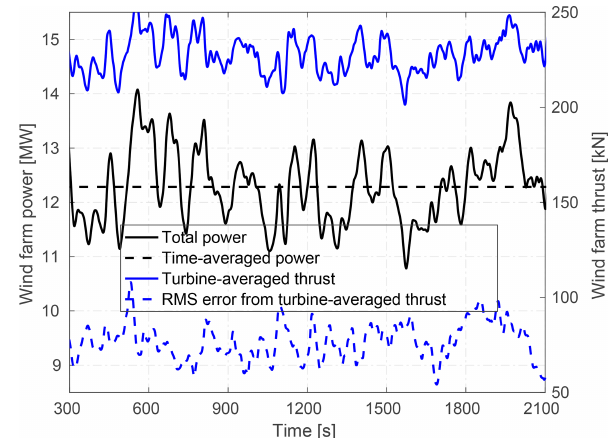
Figure 4. Wind farm power (left vertical axis) and deviations of the applied thrusts from their turbine average (right vertical axis) with locally greedy induction factors.